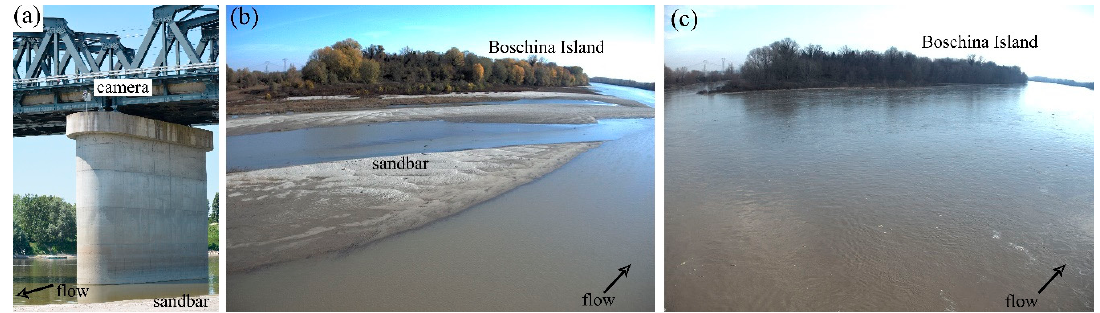
Figure 3. ( a ) Location of the camera and example of images acquired at Revere in ( b ) low flow conditions and ( c ) during the flooding event.